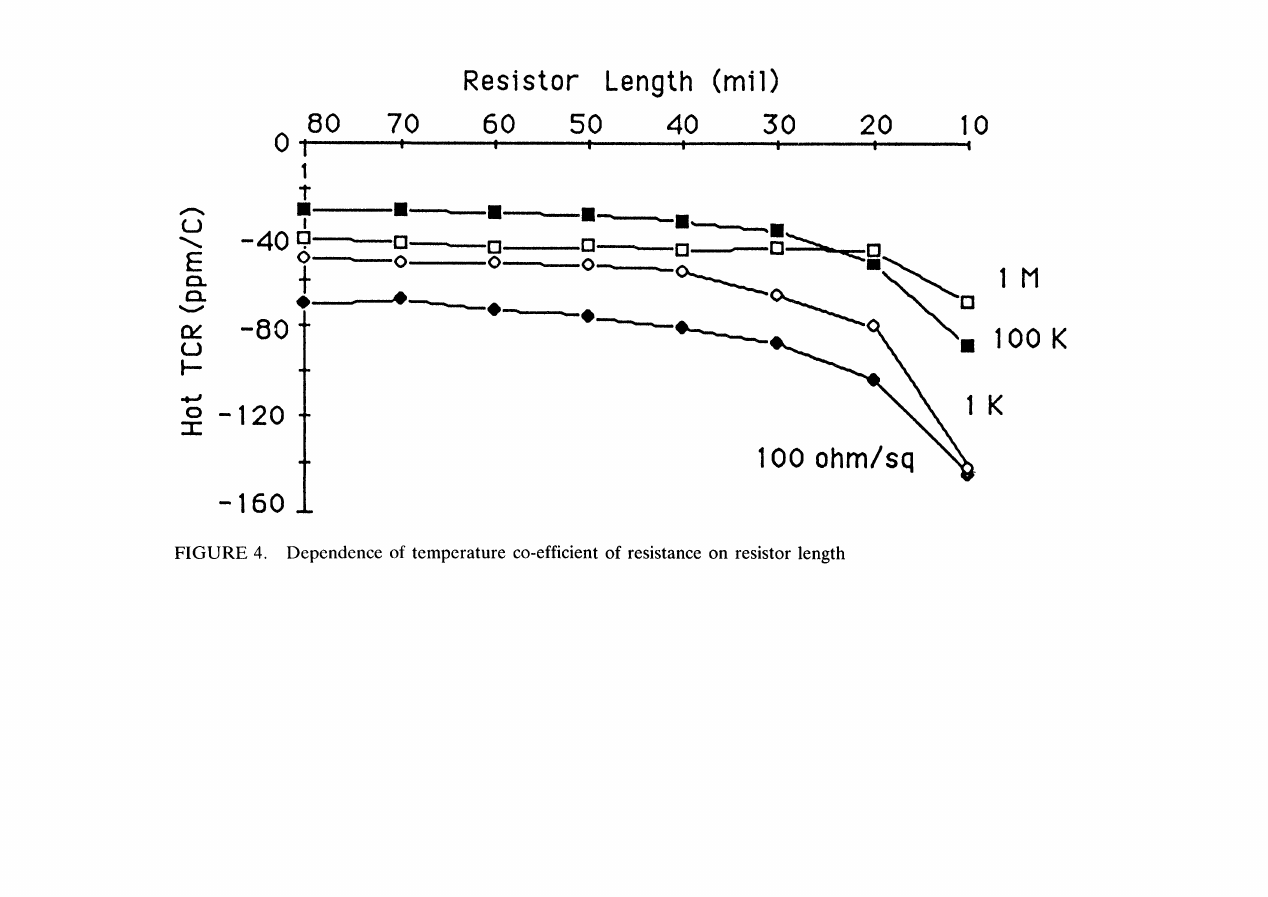
FIGURE 4. Dependence of temperature co-efficient of resistance on resistor